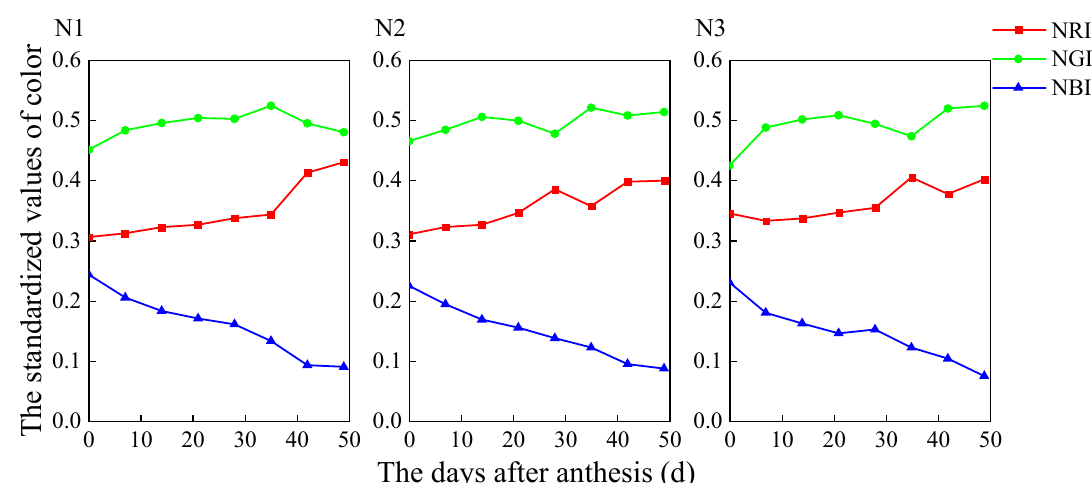
CY5 after anthesis.